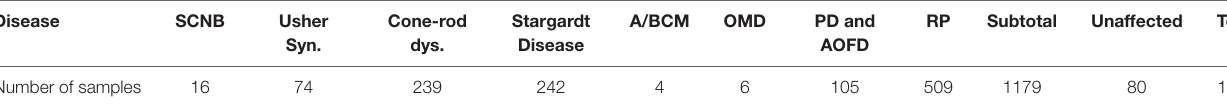
TABLE 1 | DNA samples of various inherited retinal dystrophy and unaffected controls.